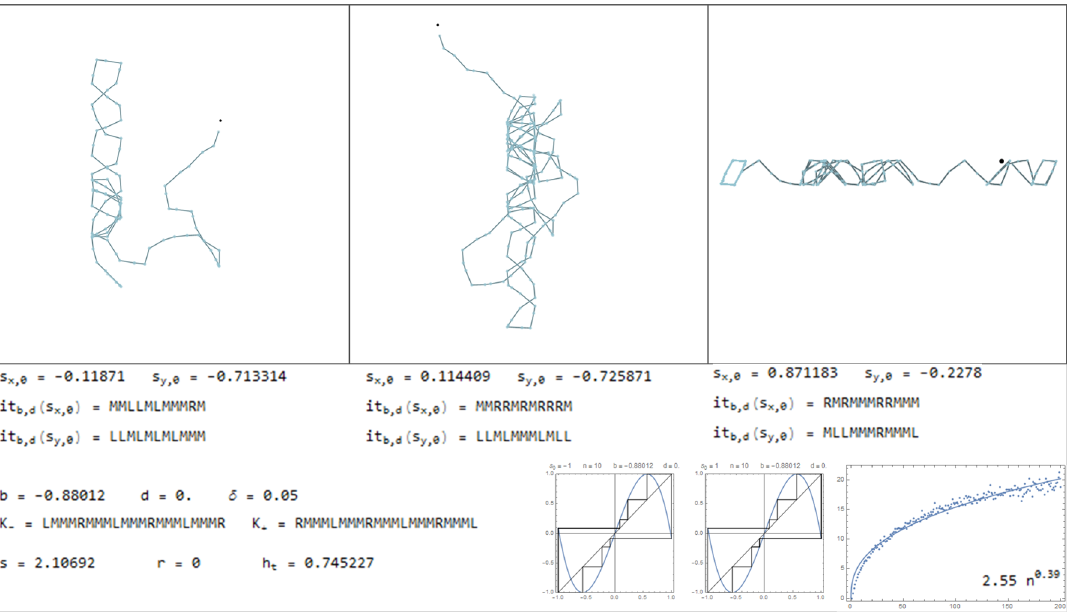
Figure 21. Trajectories produced with b = − 0.88012 and d =